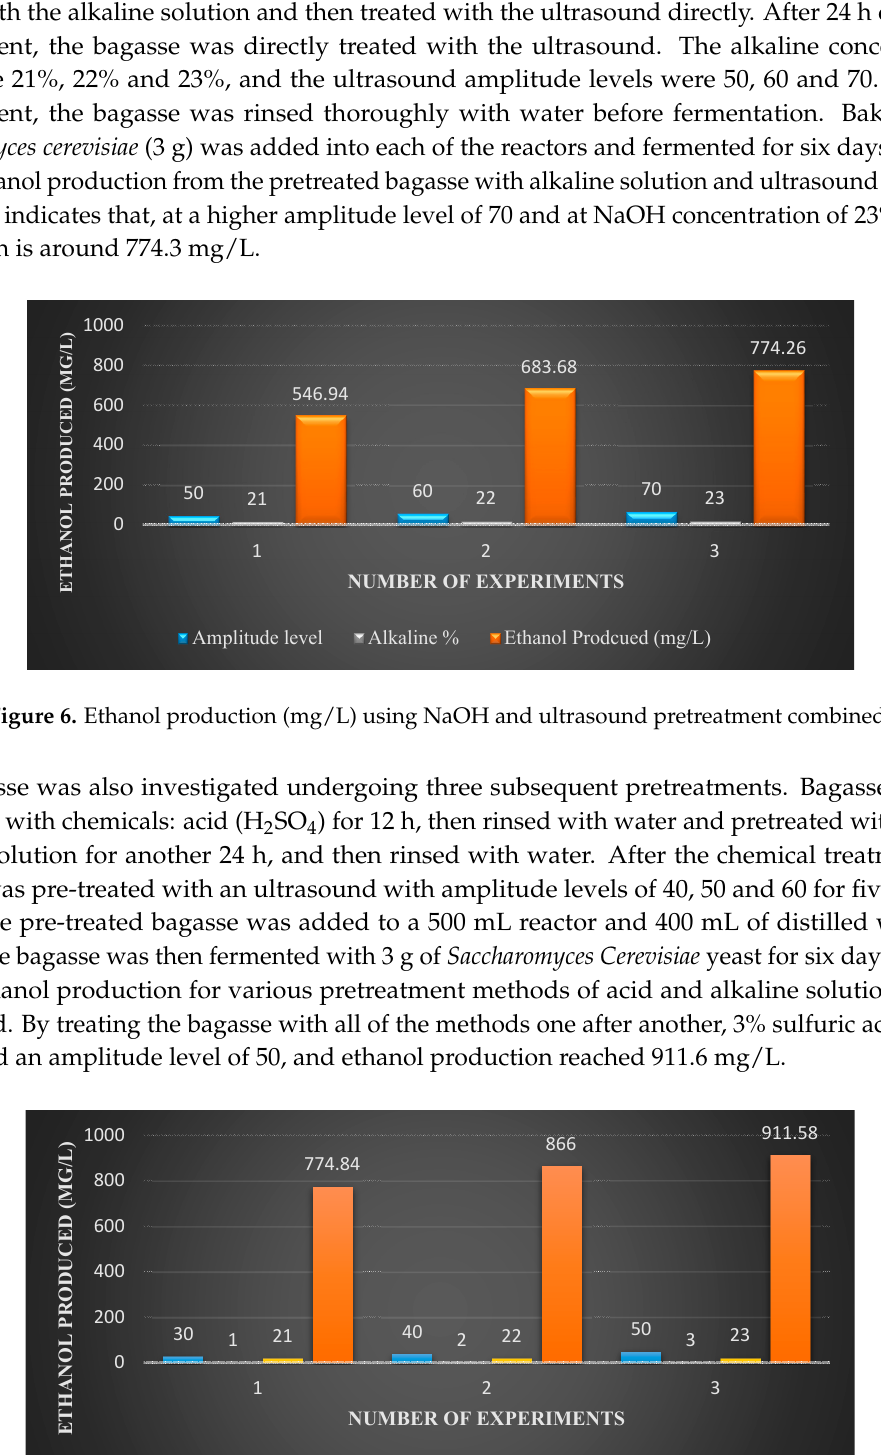
Figure 7. Ethanol production for subsequence pretreatment methods: acid, alkaline and ultrasound.